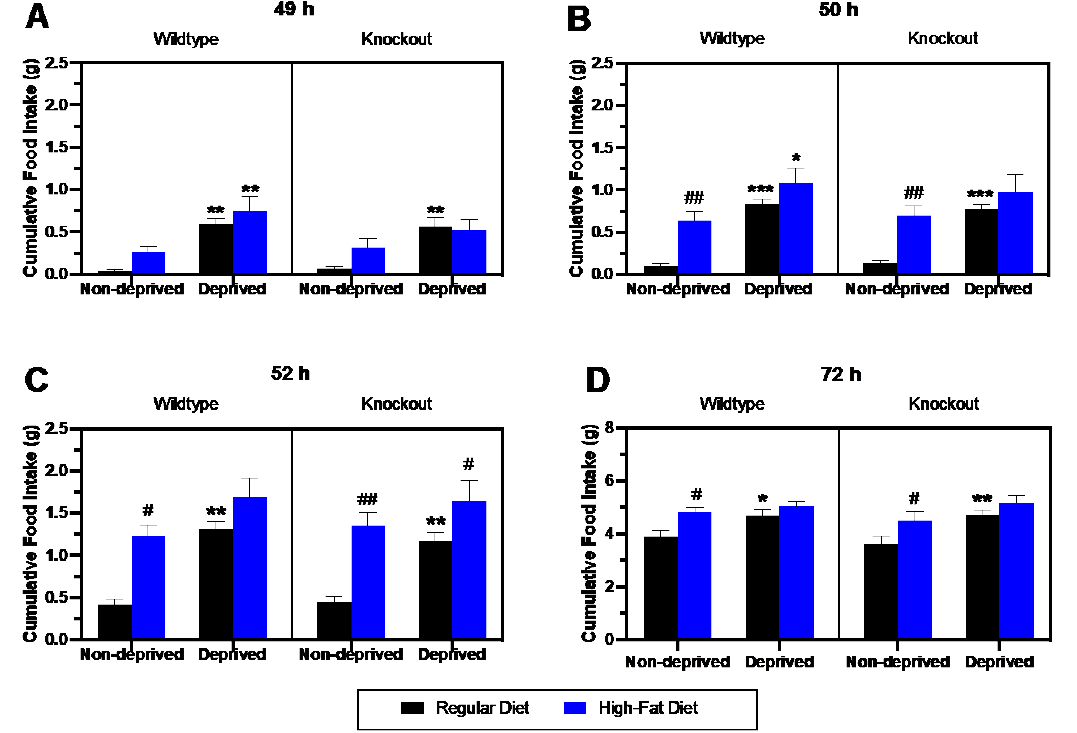
Figure 4. Comparison of food intake of wildtype (left half of the panel) and beta-endorphin knockout (right half) mice following 24 h food deprivation compared to their non-deprived controls at the end of the first (49 h, A ), second (50 h, B ), fourth (52 h, C ) and twenty-fourth (72 h, D ). * p < 0.05, ** p < 0.001, and *** p < 0.0001 signify a difference between deprived and non-deprived mice; # p < 0.05, and ## p < 0.01 signify a difference between HFD vs. RD group.